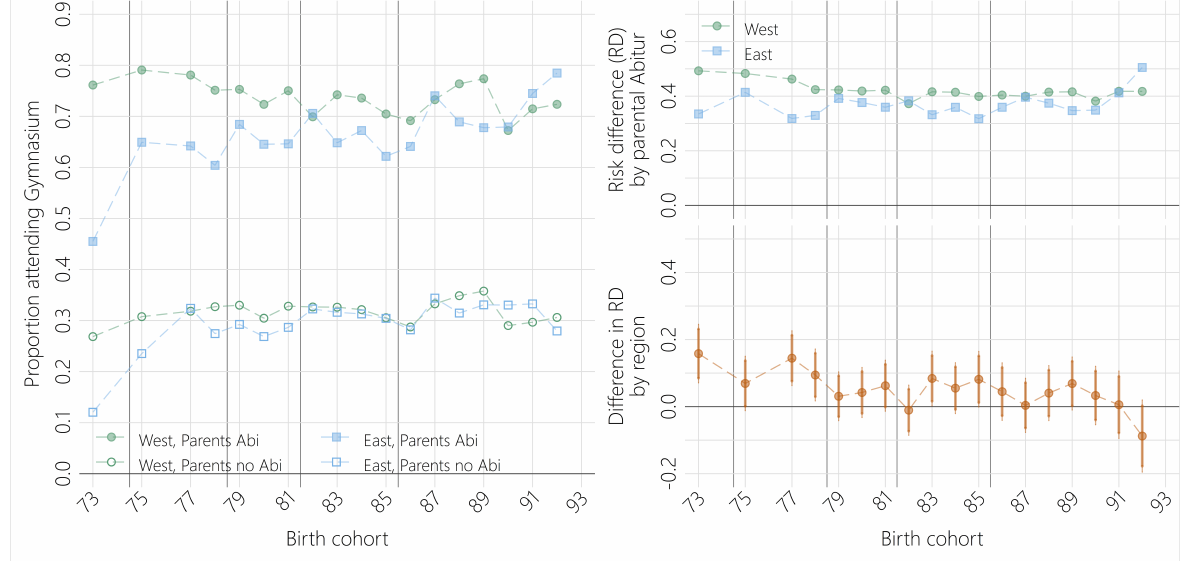
Figure 5: Change in IEO across birth cohorts in East and West Germany after reunification. Risk differences pertain to parental education. Difference in risk difference pertains to East and West Germany. The first vertical line indicates the timing of reunification. Subsequent vertical lines differentiate birth cohorts according to the timing of educational transitions after